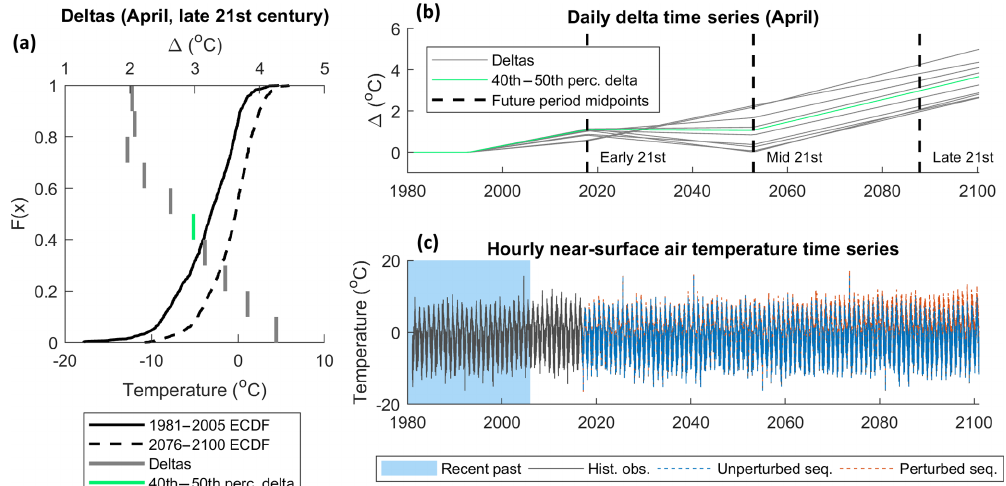
Figure 3. Example of the advanced delta-change approach when applied to near-surface air temperature data based on the RCP8.5 projections using the CNRM-CM5 GCM and CCLM4-8-17 RCM. Deltas (grey bars) derived from ECDFs (black curves) for April in the late 21st century (a) ; daily delta time series for each section of the April ECDFs (green line represents 40th–50th percentile section) (b) ; initial and perturbed future temperature time series when deltas for all months and ECDF sections are applied (c)